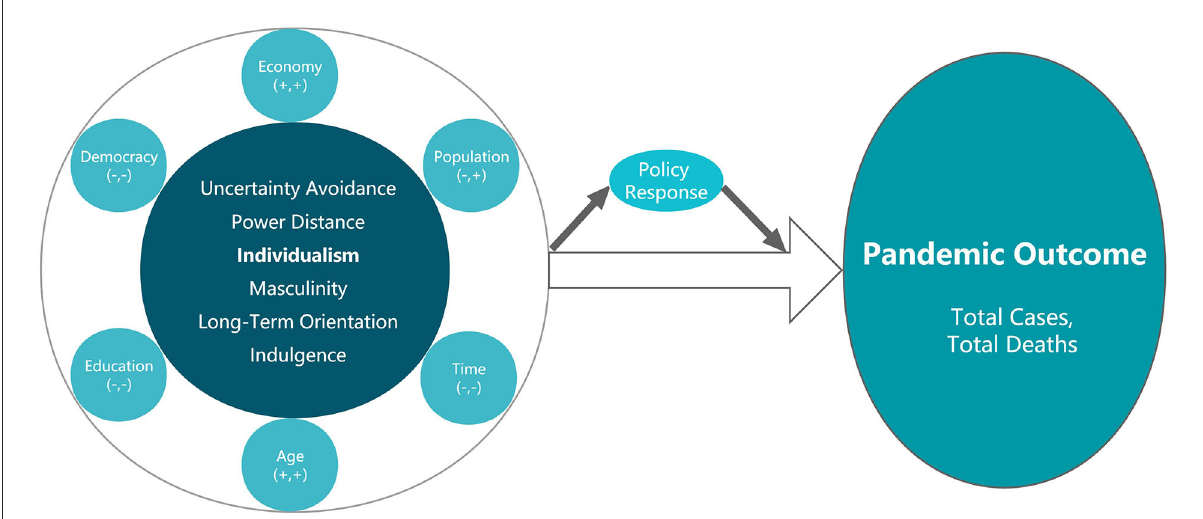
FIGURE2 Moderating effect of each control variable. Source: Drawn by the author. “ + ” and “–” in parentheses, respectively, indicate positive or negative effects of the moderating effects on the influence of culture on Total Cases and Total Deaths. For example, the economy has a